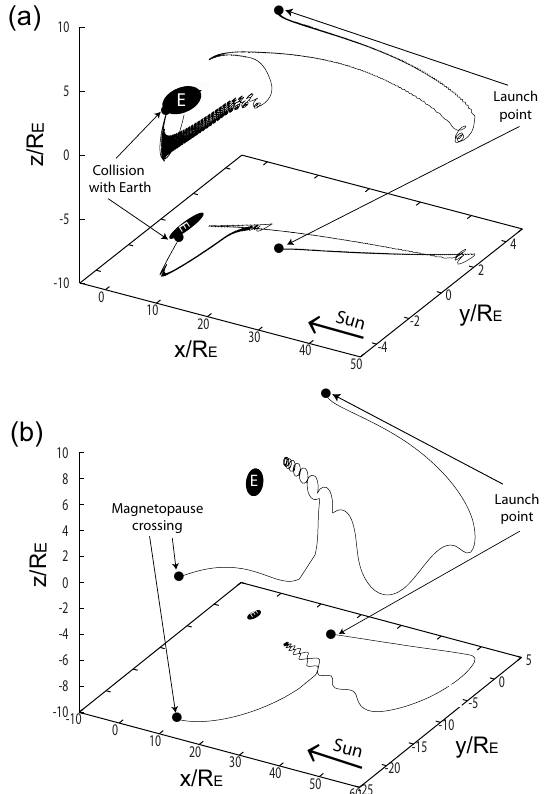
Figure 7. Three-dimensional plot of ion orbits which conclude out- side the inner magnetosphere, with initial conditions same as in Fig. 6 apart from (a) E k (t 0 ) = 0 . 5keV for H + and (b) E k (t 0 ) = 7keV for O + .